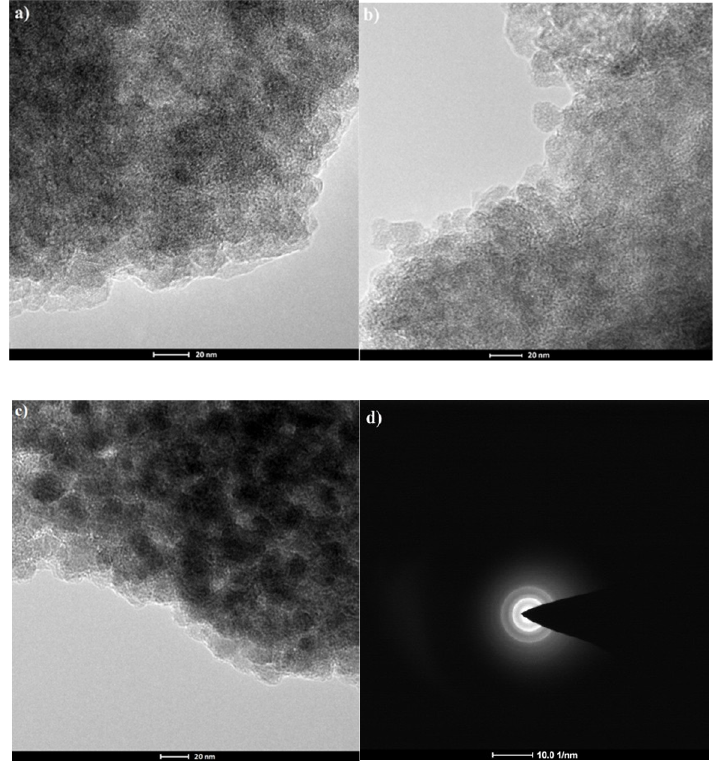
Figure 5. Transmission electron microscope (TEM) pictures of prepared magnetic nanoparticles (MNPs), ( a ) Fe 3 O 4 CS-Et(NH 2 ), ( b ) Fe 3 O 4 CS-Et(NH 2 ) 2 , ( c ) Fe 3 O 4 CS-Et(NH 2 ) 3 , and ( d ) selected area diffraction pattern (SADP) for MNPs.